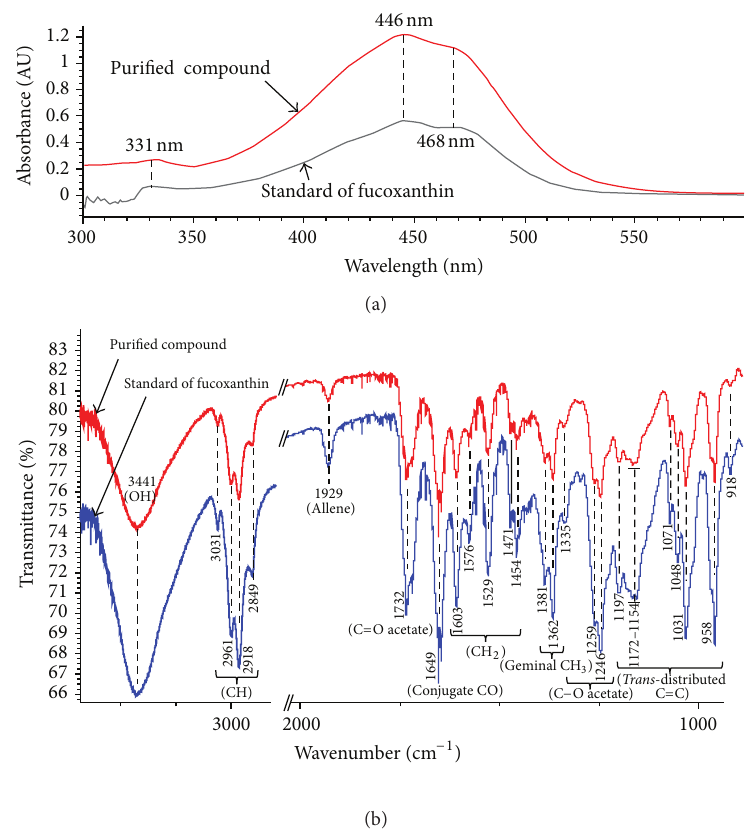
Figure 4: Characteristic UV-visible (a) and FT-IR (b) spectra of standard (fucoxanthin) and preparative TLC purified compound from H. elongata